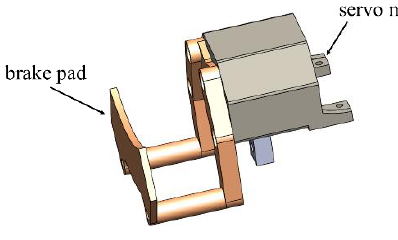
Figure 7. The server motor of the braking system.